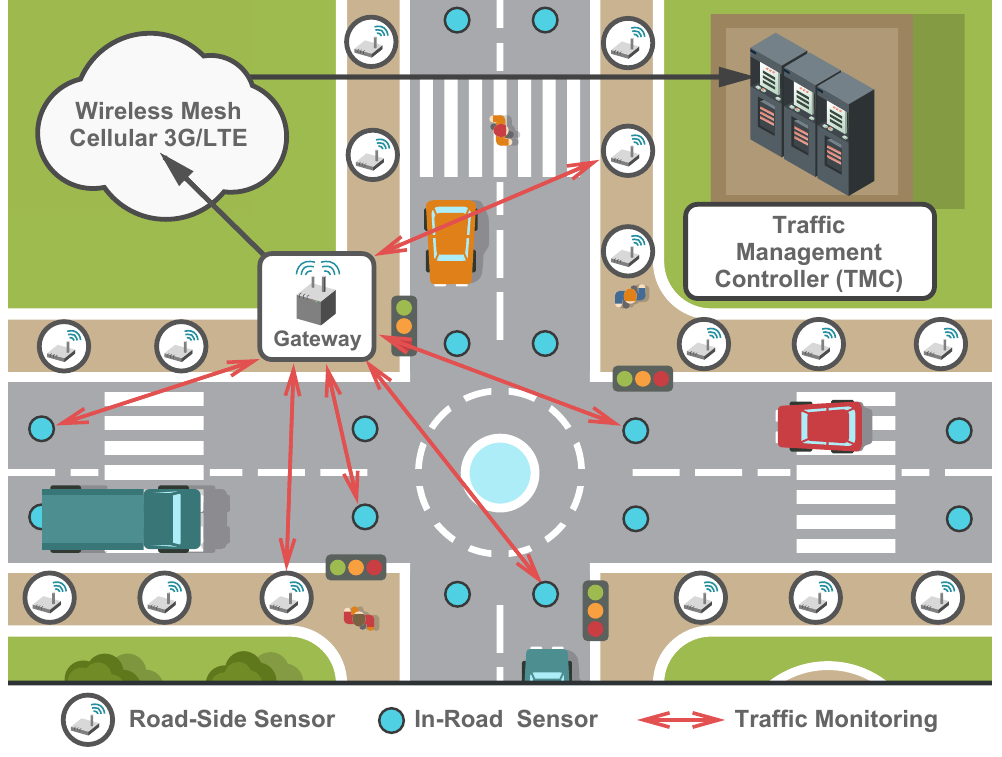
Figure 3. Communications chain of data feeds in smart